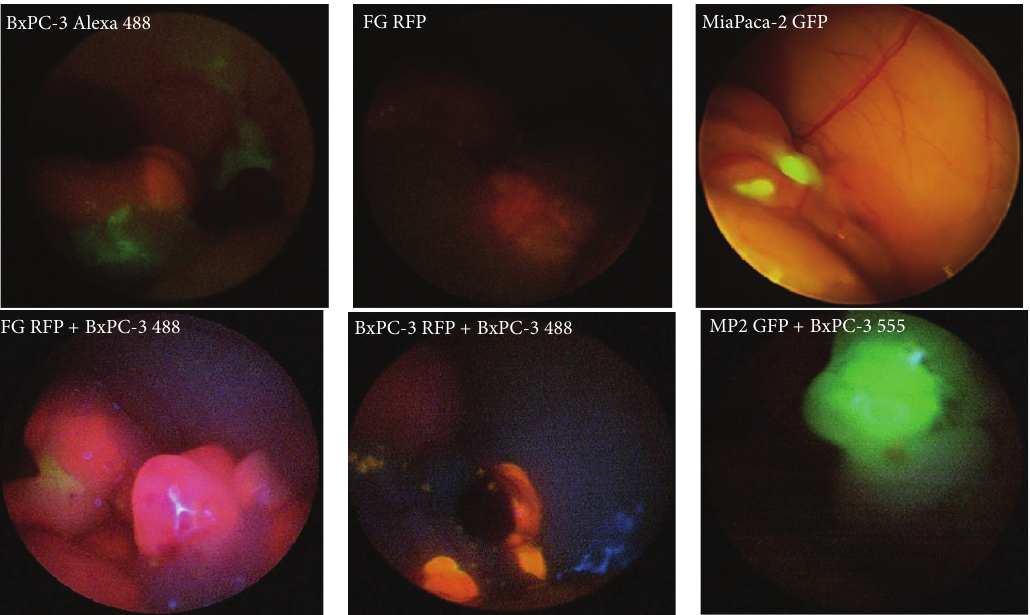
Figure 5: Laparoscopic images of the left upper quadrant in representative mouse models of human pancreatic cancer labeled with fluorophores with different fluorescence wavelengths. Fluorescence laparoscopy with the LED light source allows identification and localization of human pancreatic tumors of different fluorescence wavelengths simultaneously with improved accuracy. The combination of RFP-expressing tumor labeled with AntiCEA Alexa 488 afforded the brightest signal